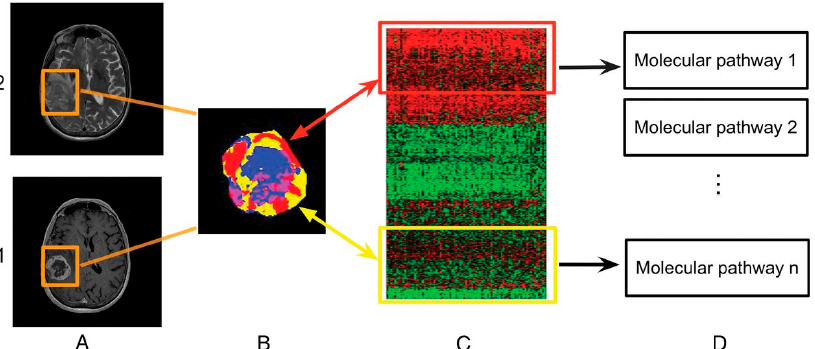
Figure 14. Linking subregional imaging to molecular profiles in GB. In this example, tumor subregions ( B ) are defined by jointly clustering on contrast-enhanced T1WI and T2WI ( A ). These subregions correspond to red (high T1WI and high T2WI), yellow (high T1WI and low T2WI), blue (low T1WI and high T2WI), and pink (low T1WI and low T2WI) areas. The defined tumor subregions enable quantitative spatial characterization, offering a means to noninvasively assess specific molecular activities ( C ) with enriched molecular pathways ( D ) [139].